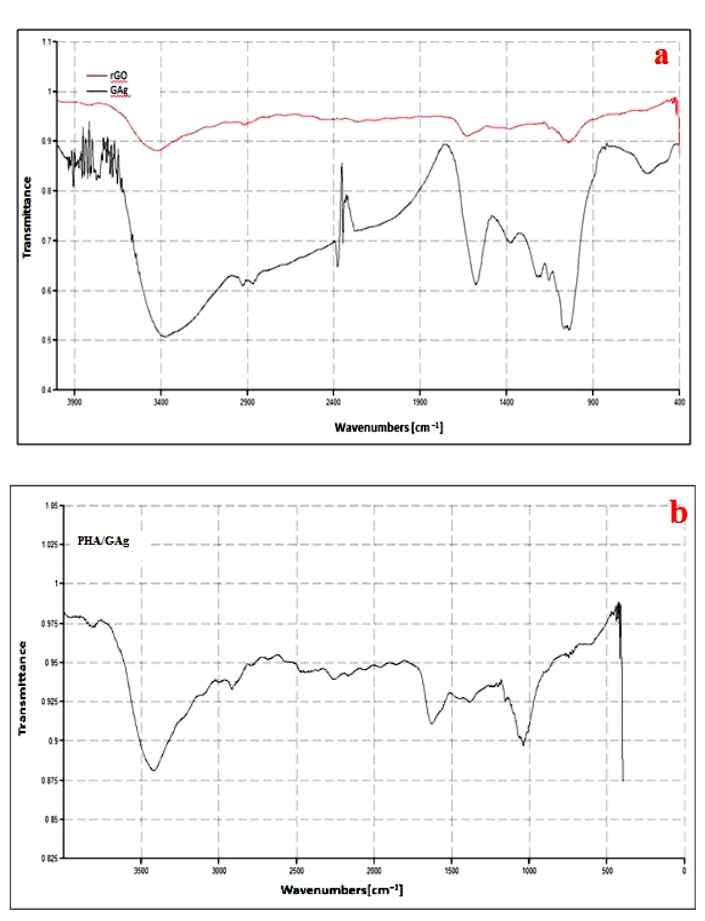
Figure 8. FTIR spectra of rGO and GAg ( a ) and PHA/GAg ( b ) nanocomposites.